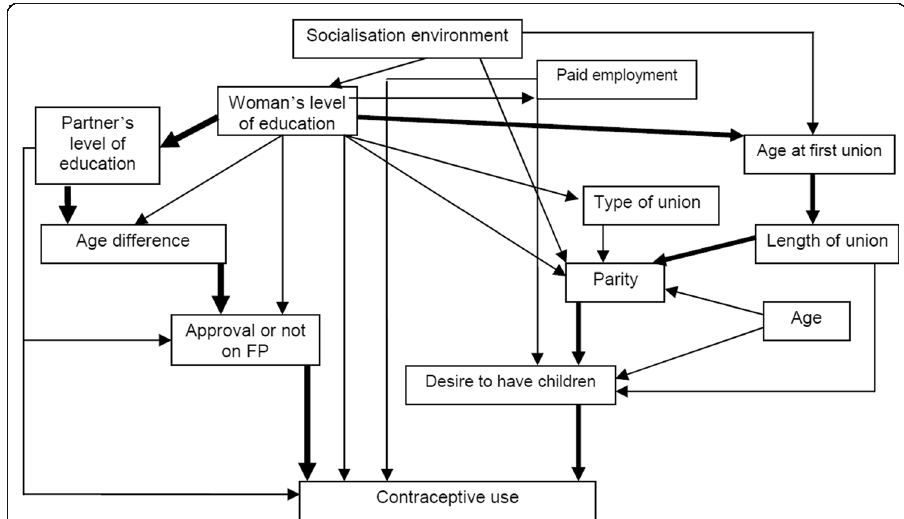
Fig. 2 An operational model of the determinants of contraceptive